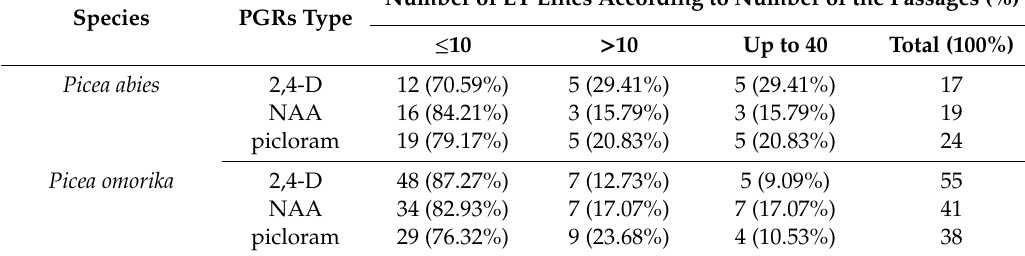
Table 2. Number (ratio) of the embryogenic lines of Picea abies and P. omorika in relationship to the plant growth regulators (PGR) type used during the induction of the embryogenic tissue (ET) lines and longevity of the obtained lines expressed as the number of